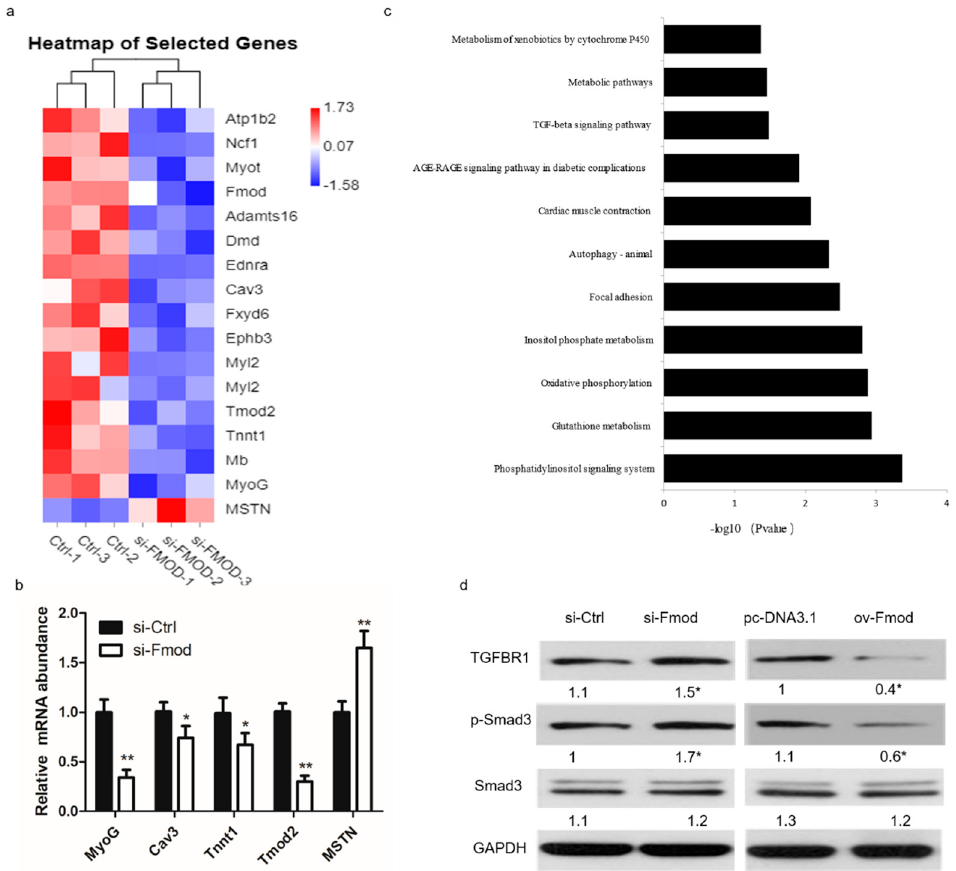
Figure 5. Gene expression analysis in Fmod-silenced myoblasts. ( a ) The heatmap of selected differentially expressed genes between myoblasts transfected with Fmod siRNA and control. ( b ) The mRNA expression levels of MyoG, Cav3, Tnnt1, Tmod2, and MSTN after transfection with Fmod siRNA and control. ( c ) Pathway enrichment of significant differentially expressed genes between Fmod knockdown and normal myoblasts. ( d ) The protein expression of TGFBR1, p-Smad3, Smad3, and GAPDH in myoblasts transfected with Fmod siRNA and plasmids. Note: * p < 0.05, ** p < 0.01.